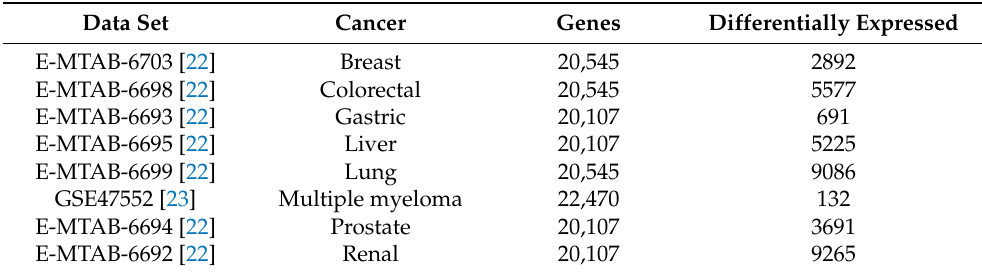
Table 5. Overview of the number of significantly differentially expressed genes per cancer type (Benjamini–Hochberg adjusted p -value ( p adj ) <